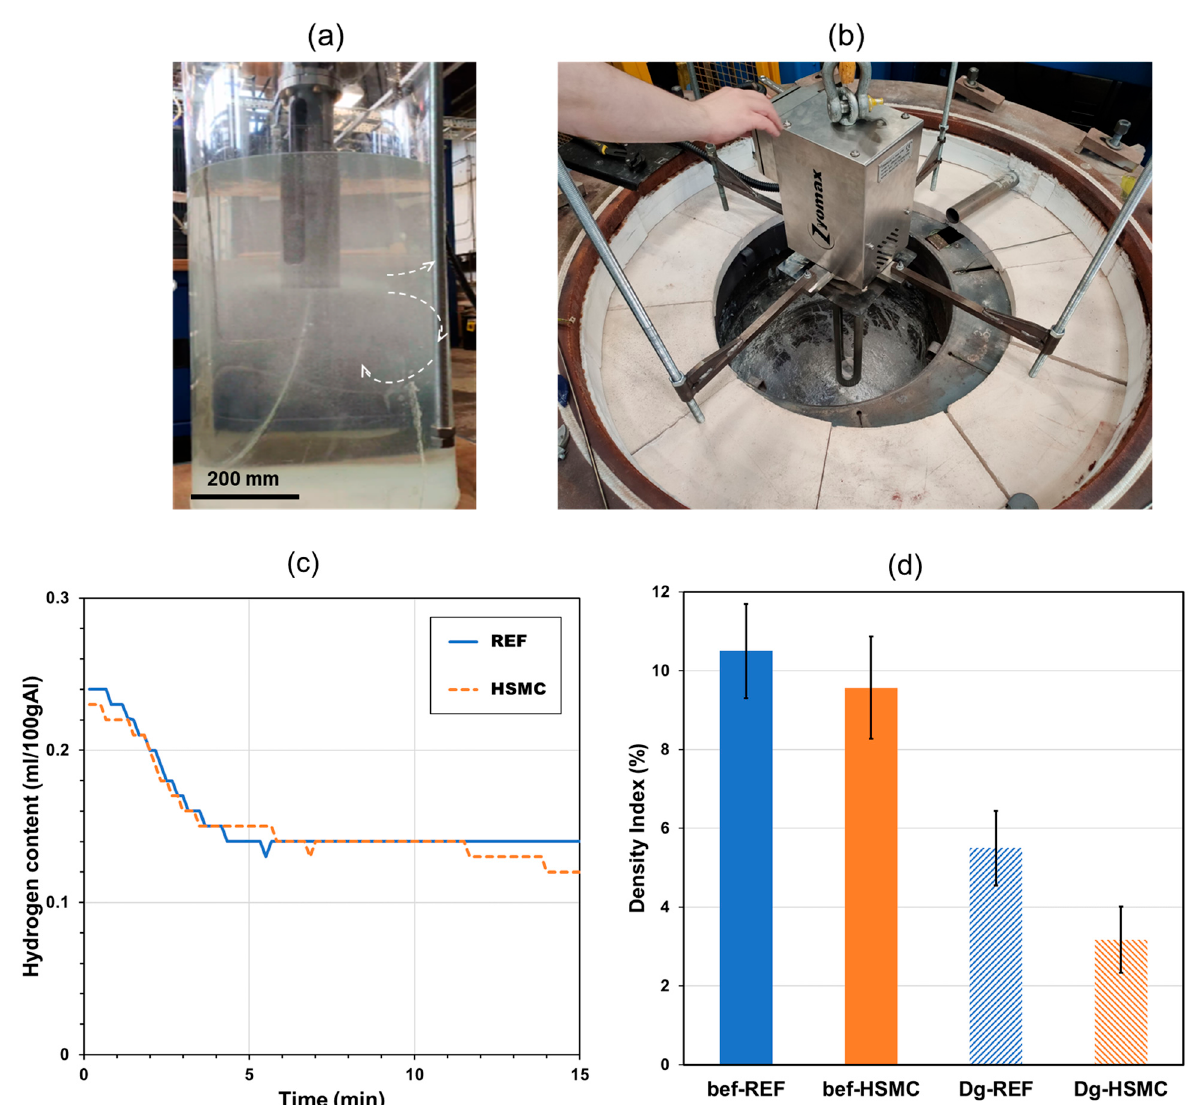
Figure 12. Large-scale activities carried out with the 90 mm HSMC unit for degassing 500 kg A356 aluminum alloy melt. ( a ) Process visualization in water; ( b ) unit implementation in the melt; ( c ) hydrogen level during degassing; ( d ) Density Index before and after degassing.